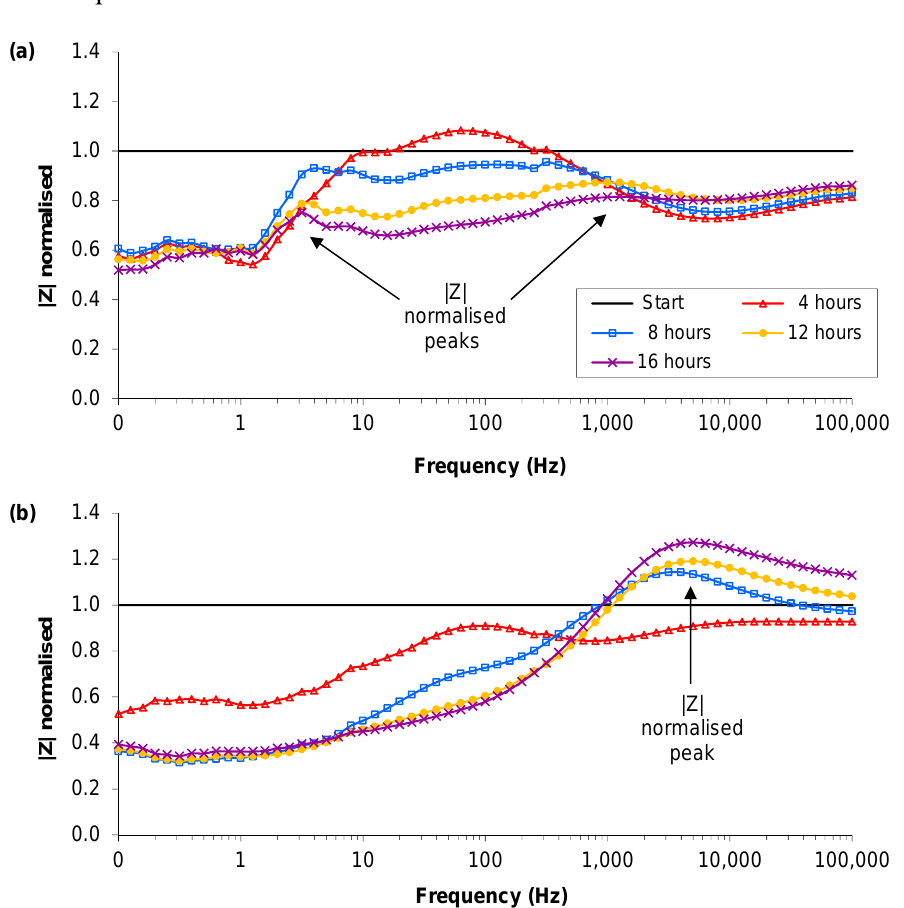
Figure 3. Examples of the normalised magnitude profiles from the single suspension experiments: ( a ) Control, MHB and 0.2% glucose; ( b ) RN4220 in MHB and 0.2% glucose. Arrows indicate peaks of